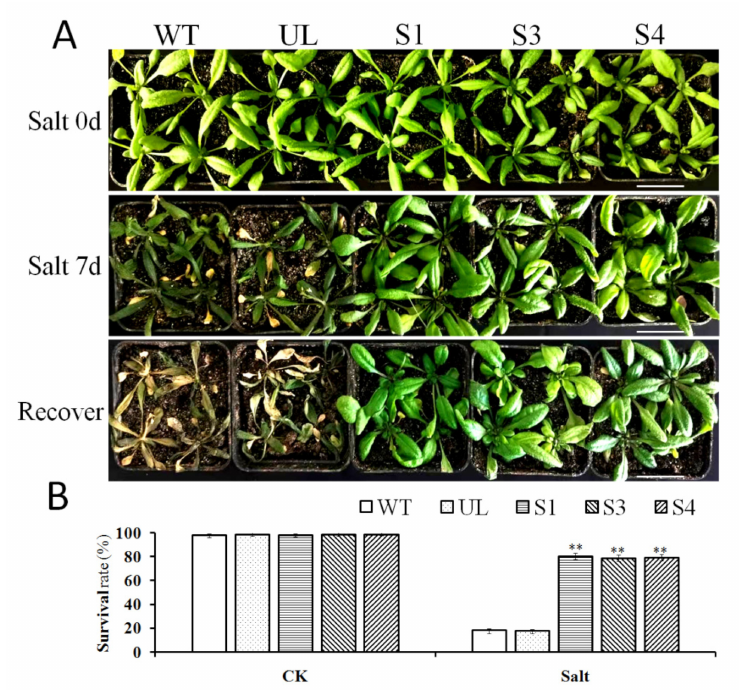
Figure 4. Overexpression of MxbHLH18 can improve salt tolerance in A. thaliana . ( A ) Phenotypes of transgenic Arabidopsis lines (S1, S3, S4), WT and UL (unload line) under salt stress and normal conditions. The scale represents 1 cm. ( B ) Survival rate of WT, UL and transgenic lines (S1, S3, S4) seedlings under control (CK) and salt stress. The data represent the mean and standard error of three repetitions. The asterisk above the column indicates that there is a significant difference compared with WT (** p ≤